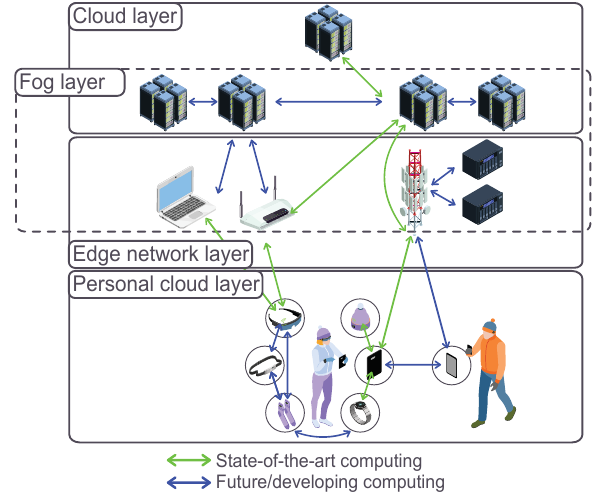
Figure 1. Most common task offloading